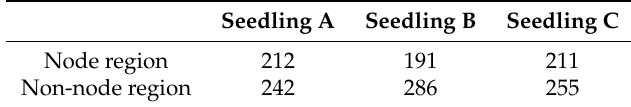
Table 2. Number of patches used for training based on Bag of Visual Words